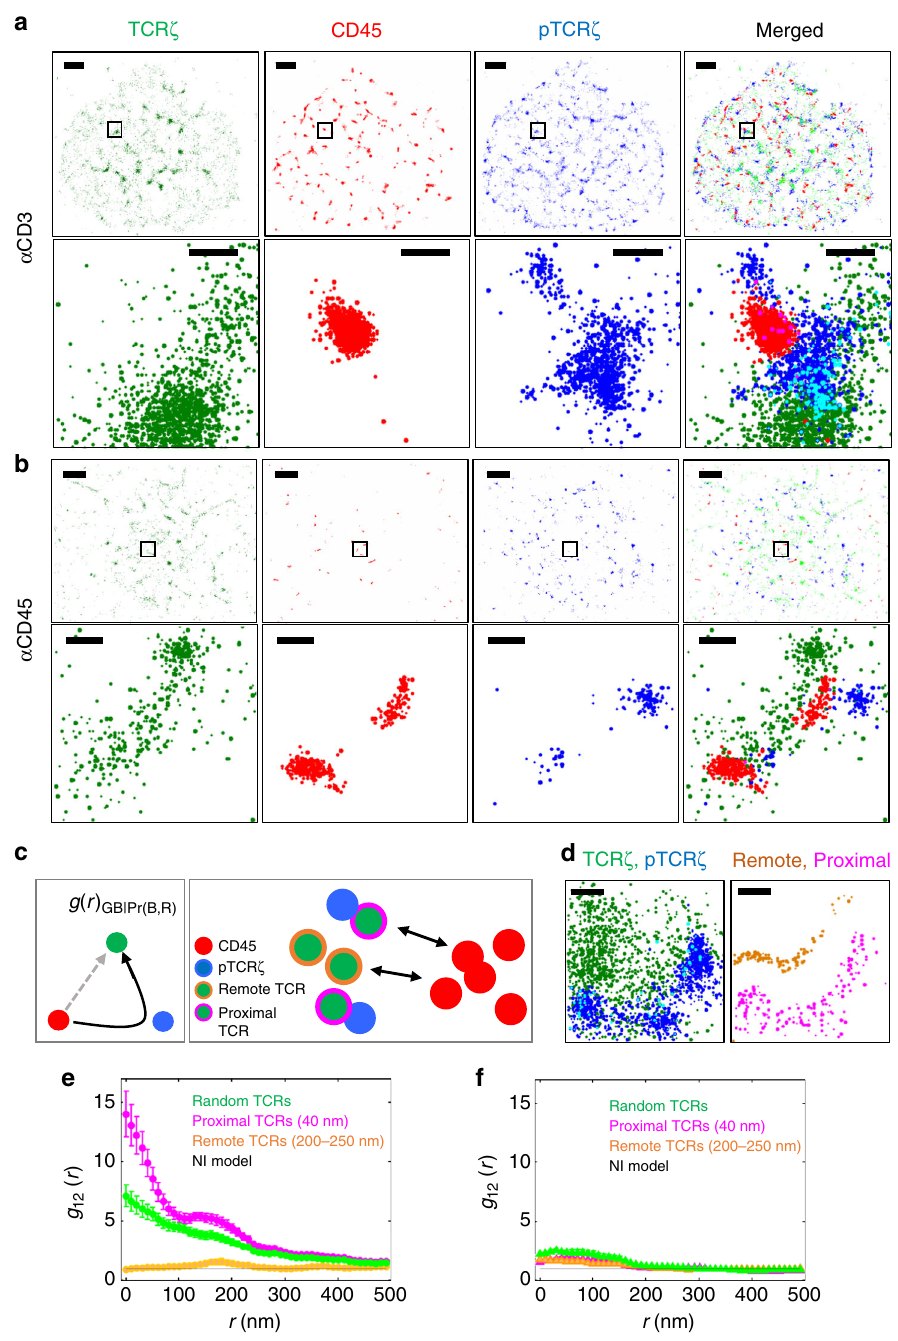
Fig. 6 TCR phosphorylation is enriched at TCR cluster edges that are proximal, yet separated from CD45. a , b Multicolour SMLM, PALM combined dSTORM images of Jurkat cells expressing CD3 ζ -Dronpa (green) and immunostained for CD45 (red) and pTCR ζ (blue) with Alexa568 and Alexa647 correspondingly, fi xed after 4 min of spreading on an anti-CD3 ( a ) or anti-CD45 ( b ) coverslips. Scale bar 2 µ m. Lower panels show enlargement of the marked areas, scale bar 200 nm. c A conditional bivariate PCF analysis between TCR and CD45 molecules as a function of TCR-pTCR distance (left). (right) Illustration of the process, TCR (green) are categorized into subpopulations of TCR: 1. Proximal TCR (green with magenta outlined) with a distance < 40 nm to pTCR (blue). 2. Far TCR (green with orange outlined) with a distance of 250 < d < 200 nm to pTCR (blue). Then PCF is calculated to the subpopulations with CD45 (red). d An example of the process, as a function of the distance from pTCR (blue), Proximal TCR (green) are coloured with magenta and far are coloured with orange, scale bar 200 nm. e , f Conditional bivariate PCF analyses between TCR and CD45 molecules as a function of TCR-pTCR distance of Jurkat cells fi xed after 4 min from dropping on e anti-CD3-, or f anti-CD45-coated